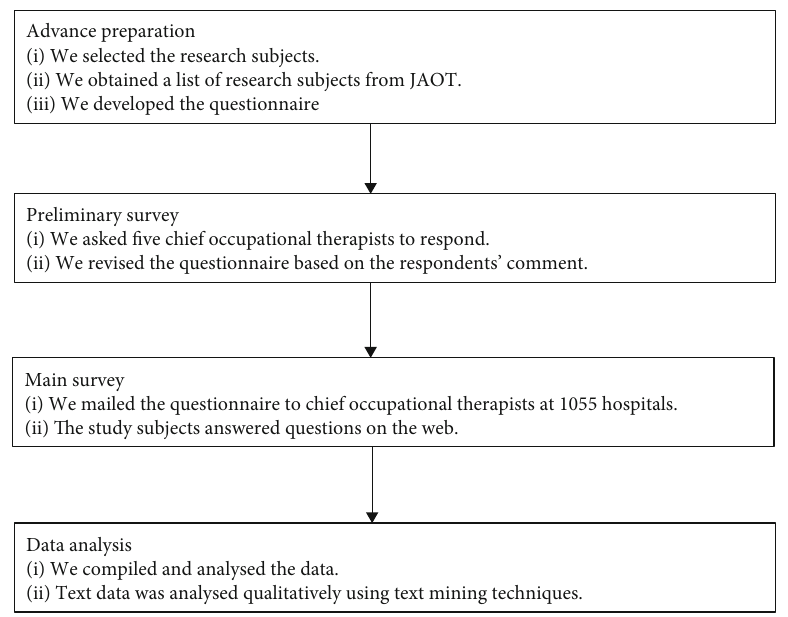
Figure 1: Overview of survey development and implementation